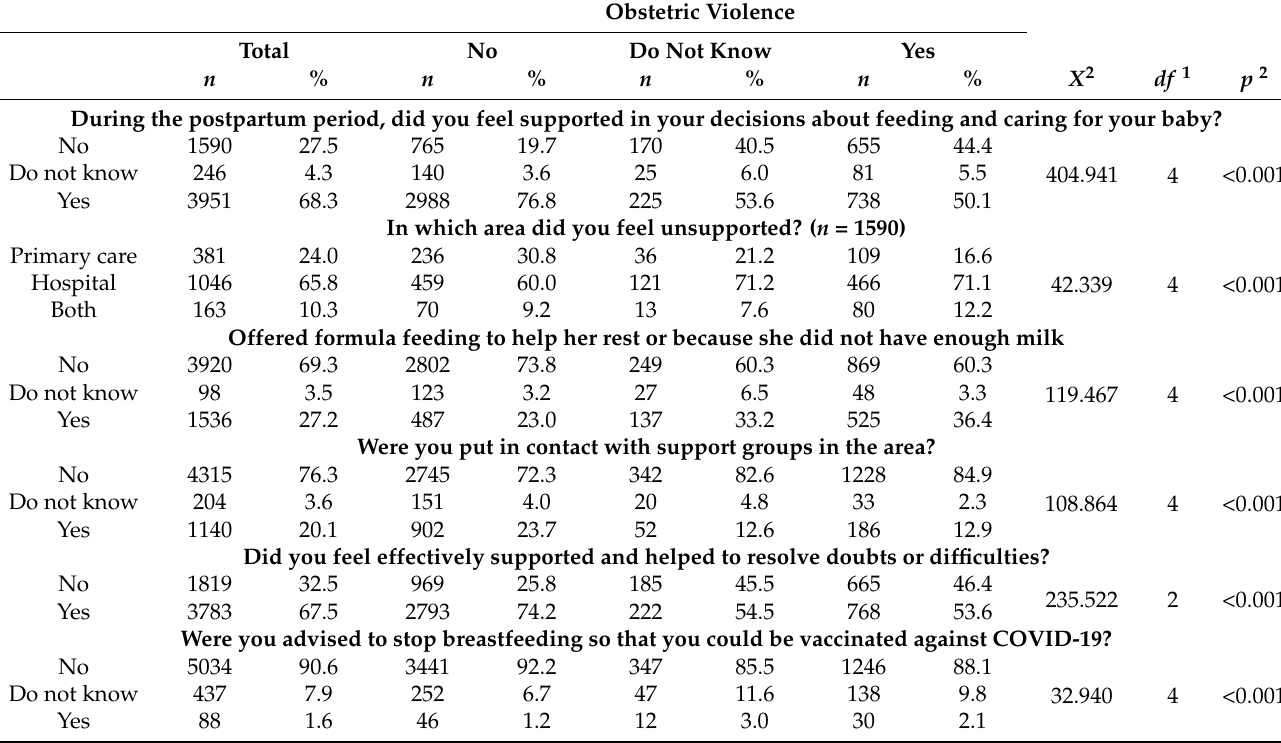
Table 3. Comparative analysis of variables on breastfeeding and obstetric violence ( n = 6060).